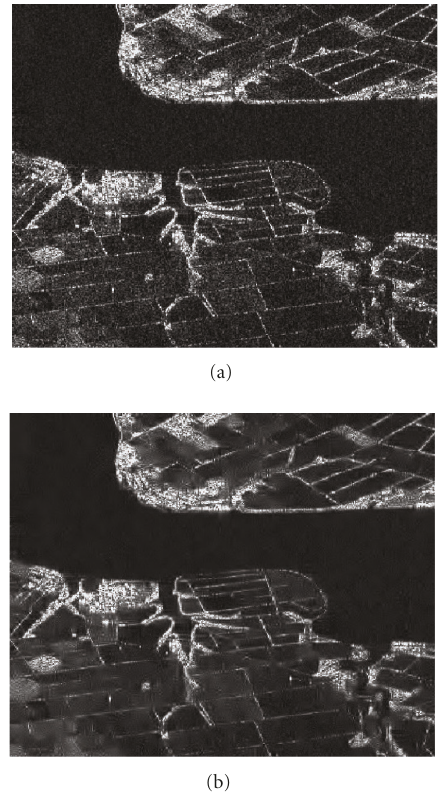
Figure 3: Original SAR image (a) and the output image after apply- ing LADCT-1 (b).